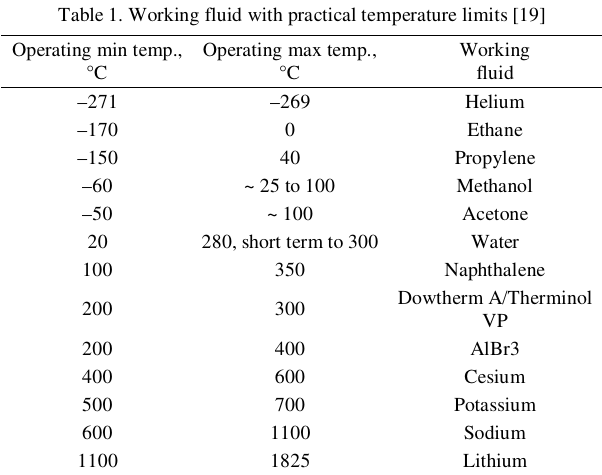
Table 1. Working fluid with practical temperature limits [19] Operating min temp., °C